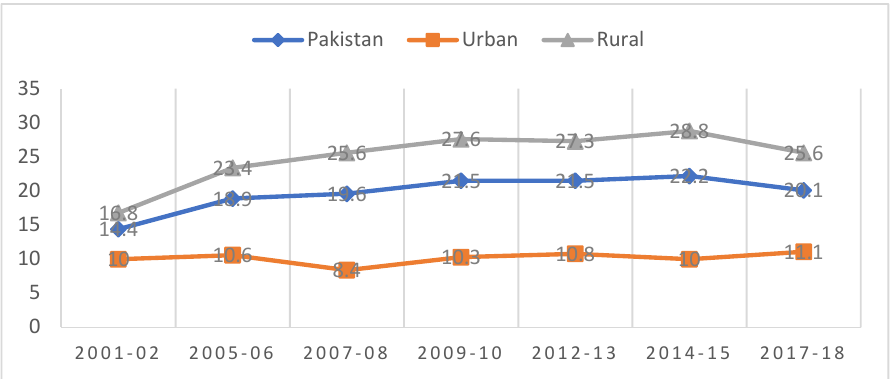
Figure 1. Region-wise and overall trends in the FLFP rate. Source: LFS survey various reports.